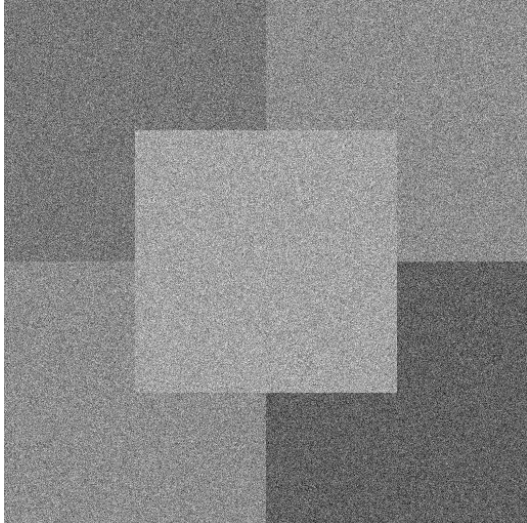
Figure 5. An example of the noisy input image at σ = 1 in Example